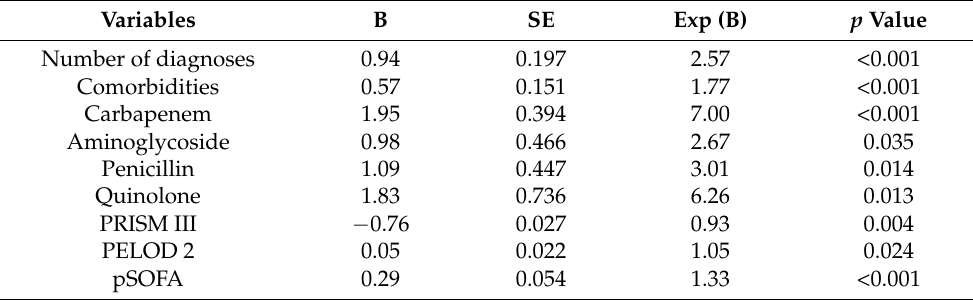
Table 3. Logistic regression analysis of risk factors related to acute kidney